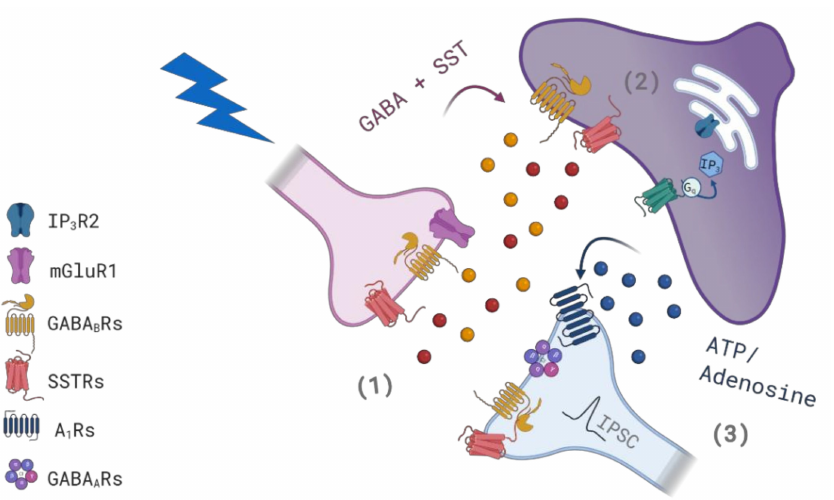
Figure 13. Schematic of the proposed cellular and molecular mechanism for IPSC amplitude mod- ulation after SST interneuron hyperactivity. (1) An intense stimulation of SST interneurons in the VCx induces the release of GABA and somatostatin that, through activation of neuronal SSTRs, induces a reduction of IPSC amplitude in PNs, i.e., disinhibition of PNs. (2) Simultaneous activation of GABA B Rs in astrocytes triggers IP 3 R2-mediated Ca 2+ elevations that are modulated by activa- tion of astrocytic SSTRs. (3) Astrocytes release ATP/adenosine that by activating A 1 Rs, probably postsynaptic, favors an increase in IPSC amplitude that counterbalances the disinhibition of PNs. In the hippocampus, SST interneuron stimulation evokes an astrocyte Ca 2+ response